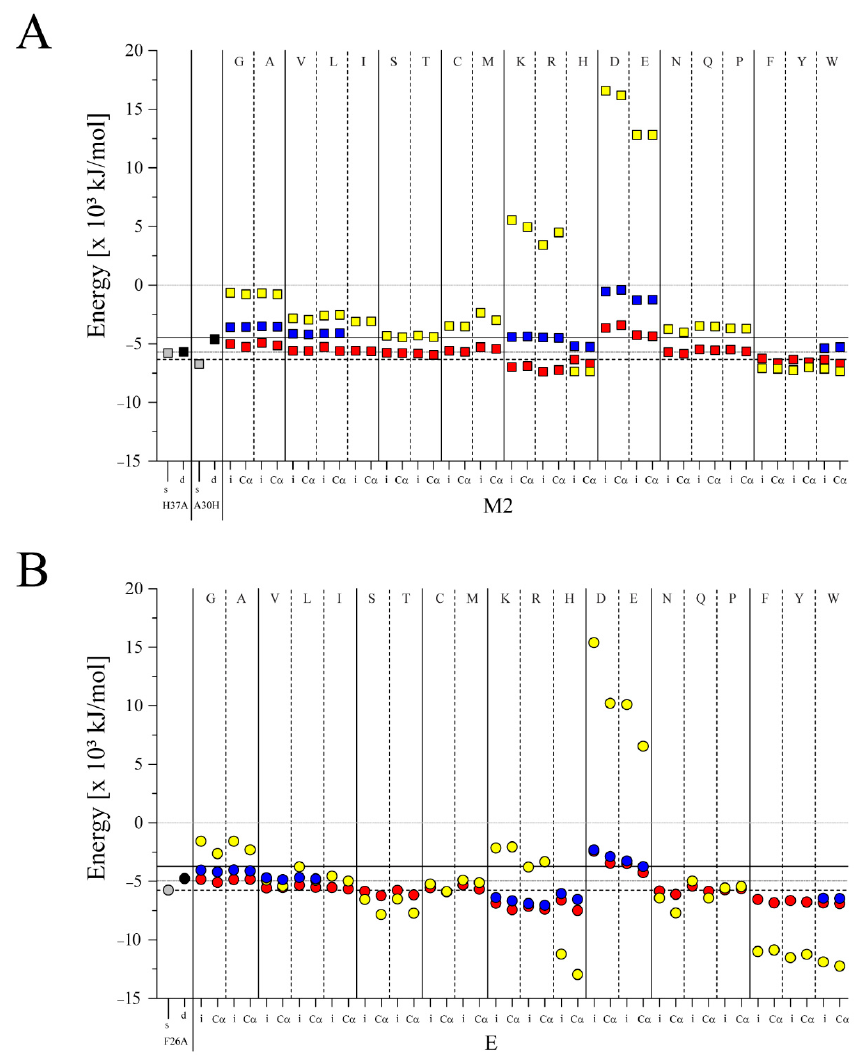
Figure 3. First ranked (1r) estimated binding energies (EBEs) of single helical poly-peptides (pp’s) assembled with target peptides as well as with itself. Each of the single pp’s generated for each of the 20 amino acids is docked to ( A ) M2 (PDB ID: 1NYJ) with the EBE values marked as squares and ( B ) to a truncated version of E (PDB ID: 5X29), E t , marking the EBEs with circles. The values are calculated for CG-pp’s modeled either as ideal helices (i) or as helices for which the C α atoms adopt the same coordinates as the experimental structures (C α ) and being assembled with oligomeric M2 or E bundles. For both plots, individual single pp’s are assembled synchronously (s-screening, s) with three TMDs (1+3) of M2 or four TMDs of E (1+4) (red), as well as 4 (in ( A )) and 5 pp’s (in ( B )) with themselves (yellow). In addition, the pp’s are docked using dimeric docking (d-screening, d) in which three or four of the TMDs of M2 and E, respectively, were taken from the respective crystal structures and docked with the pp (blue). Docking of mutants, H37A and A30H for M2 and F26A for E, are shown for s-screening (grey) and d-screening (black). The pp’s are either used as ideal helices, marked with i, or as helices for which the C α atoms adopt the same coordinates as the experimental structures, marked with C α . Reference lines are marking the EBEs of (i) the crystal structures of M2 e and E t (black lines), (ii) the 1r redocked M2 e ad E t structures using s-docking, s M2 e and s E t , (black dashed line), and (iii) the 1r redocked M2 e and E t structures using d-docking, d M2 e and d E t (grey line). For EBEs see Supplementary Table